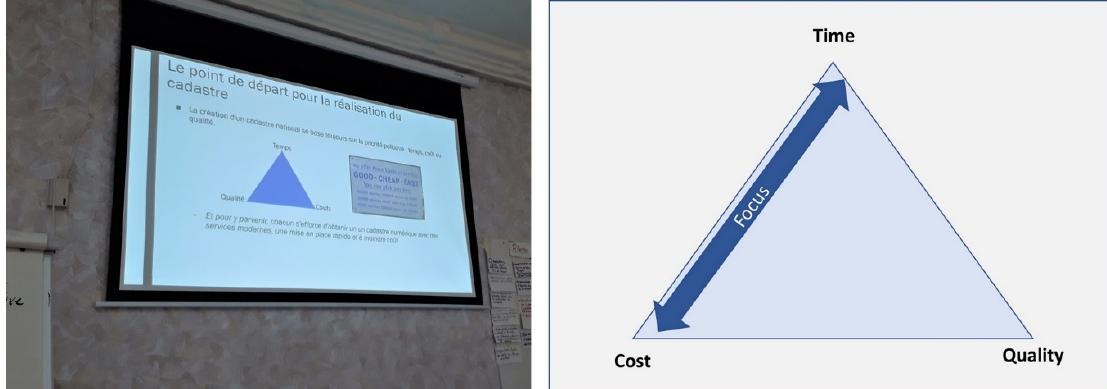
Figure 4. Purpose workshop and the iron triangle with the chosen